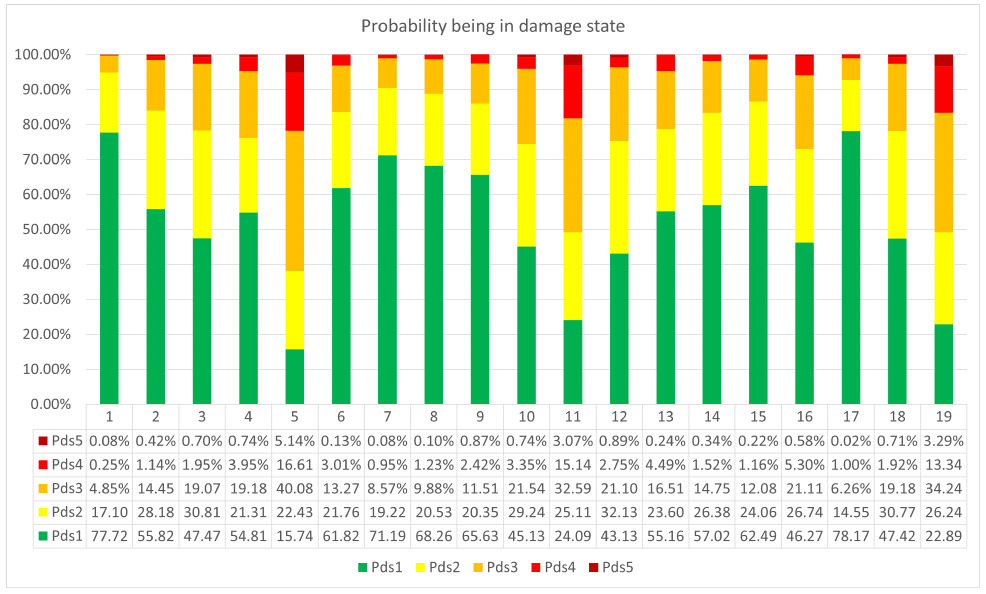
Figure 4. Probability of damage state for each of 19 RC